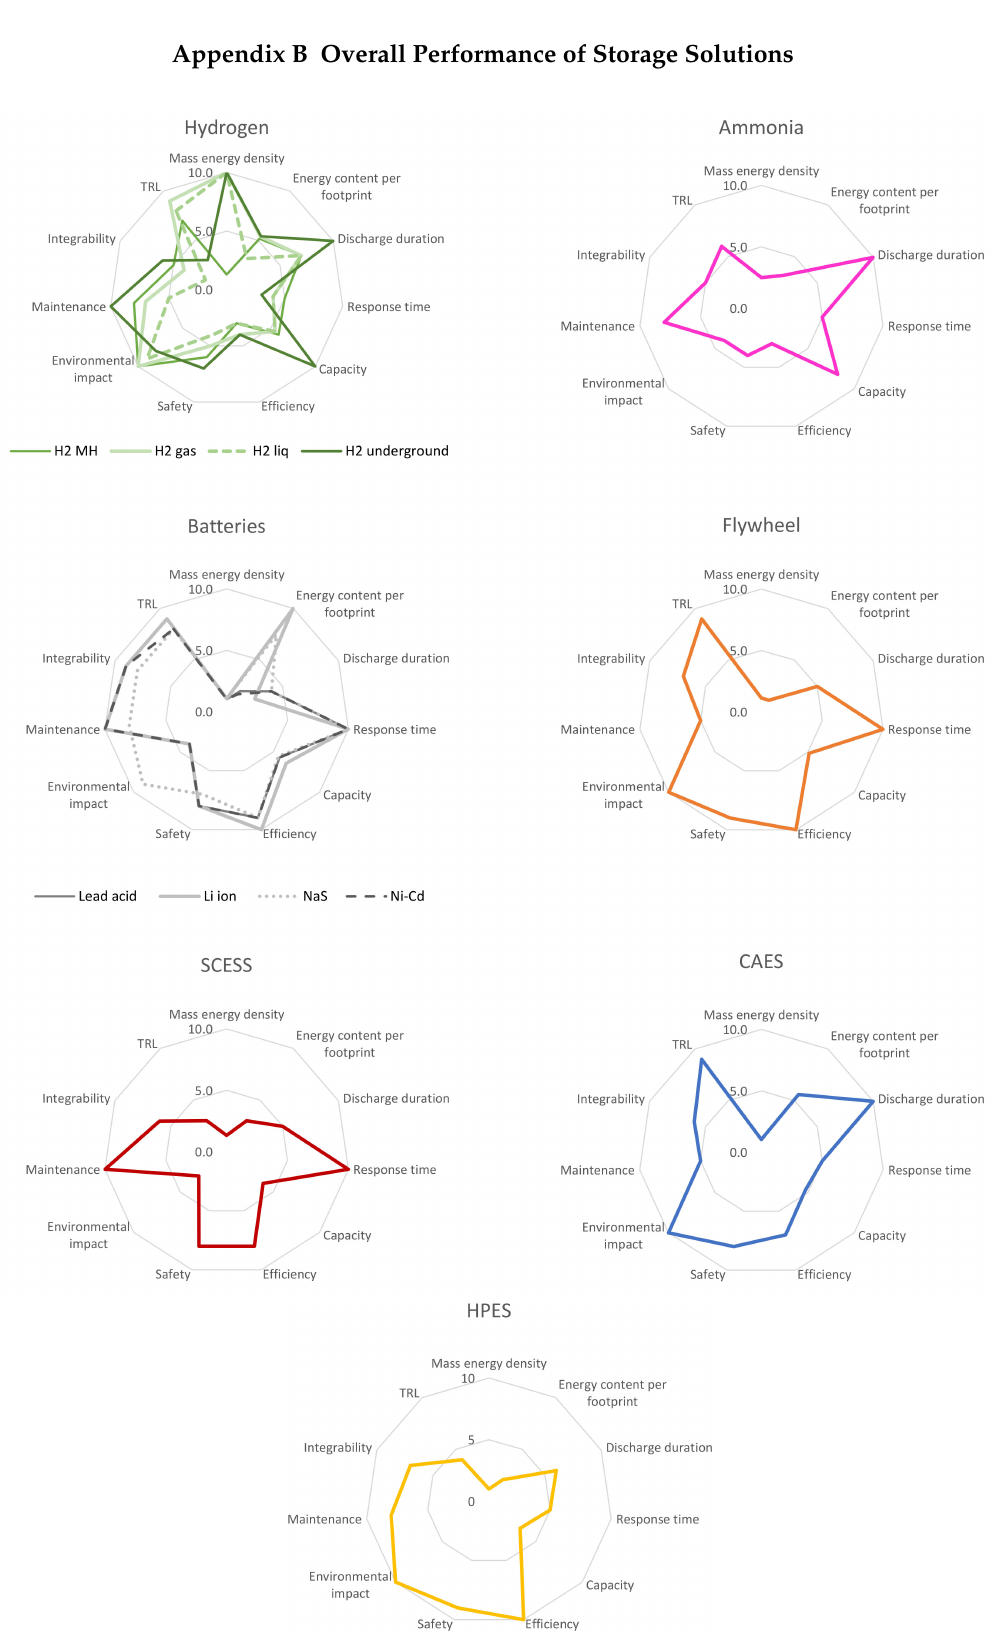
Figure A1. Spider charts of Energy Storage Systems for each